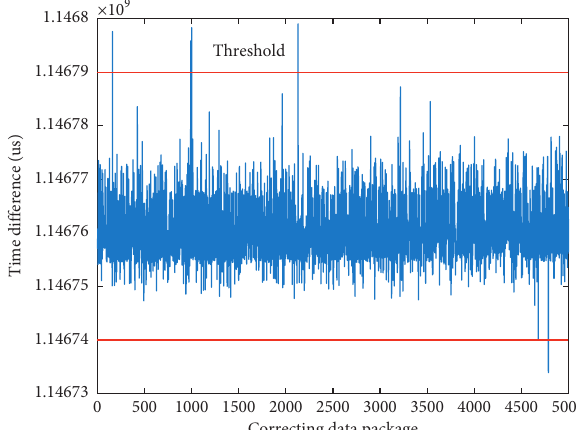
Figure 4: Delay jitter and singular values which beyond the threshold in calibration